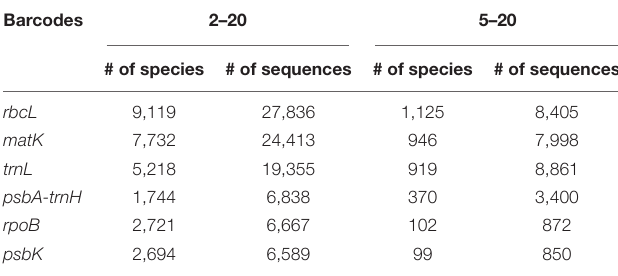
TABLE 2 | Number of species and sequences in the datasets used in this